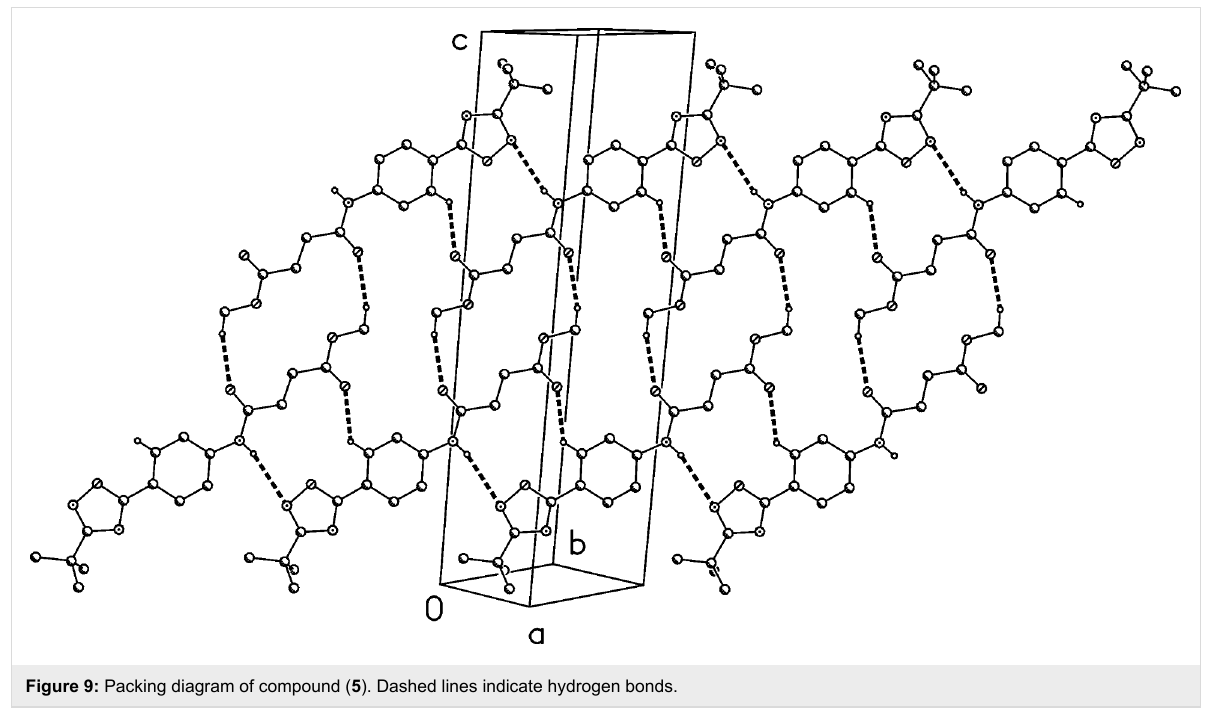
Figure 9: Packing diagram of compound ( 5 ). Dashed lines indicate hydrogen bonds.